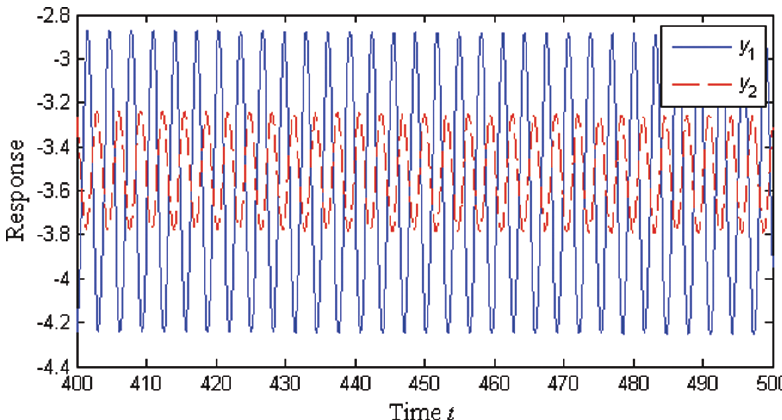
Fig. 16. Time history with feedback control, τ = 4.